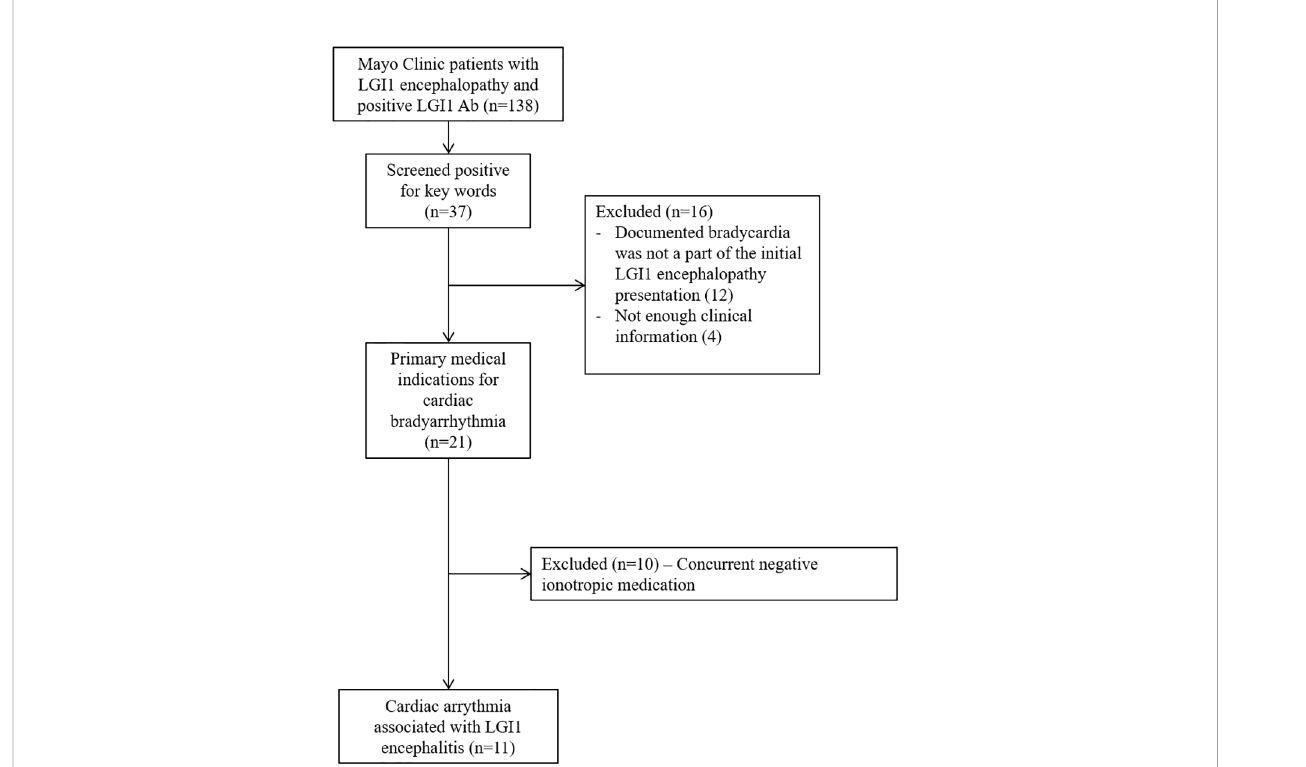
FIGURE 1 Flowchart depicting search strategy for identi fi cation of patients cardiac arrythmia within 6 months of LGI1 neurological